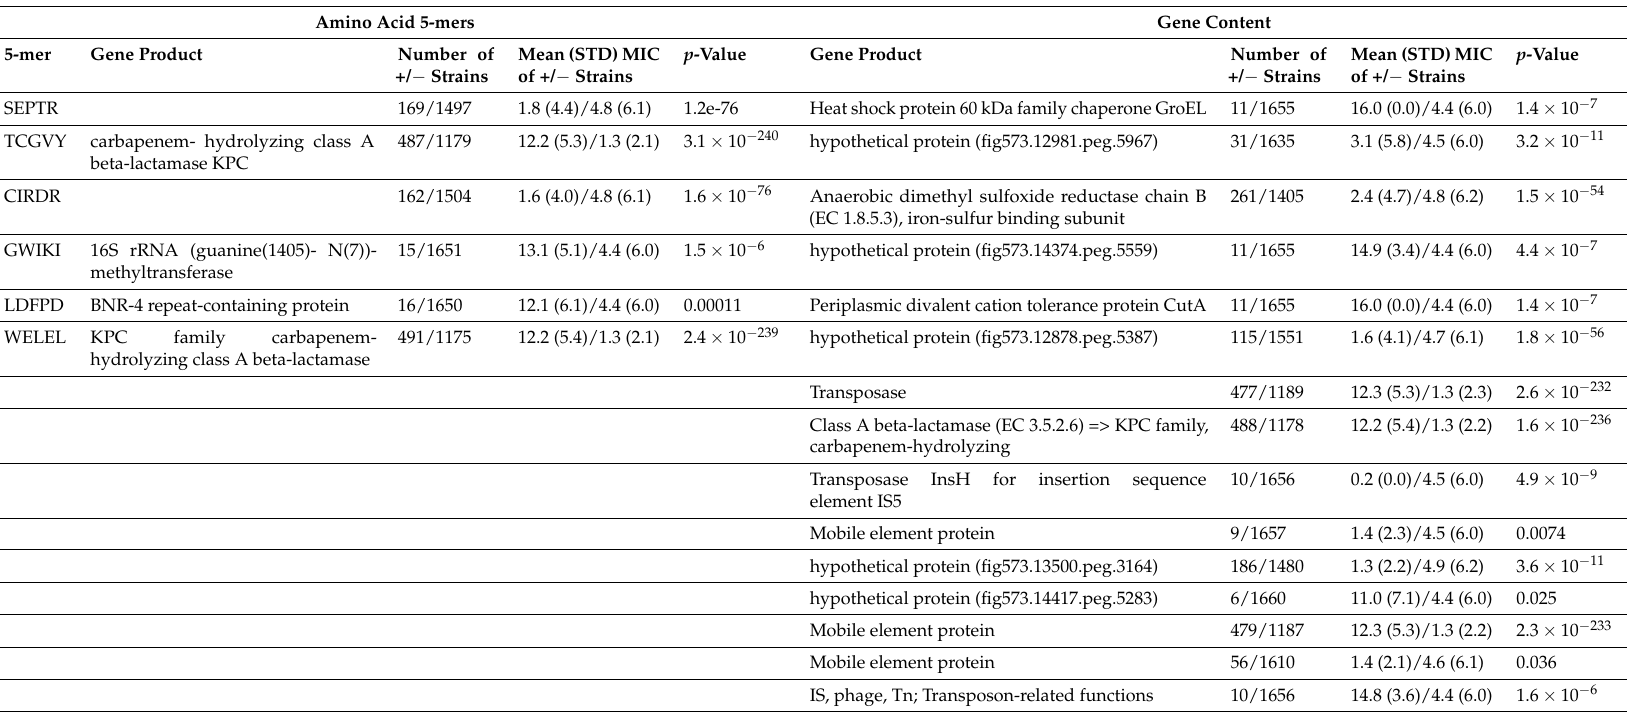
Table A7. Important genes found for K. pneumoniae and imipenem by amino acid 5-mer gene content